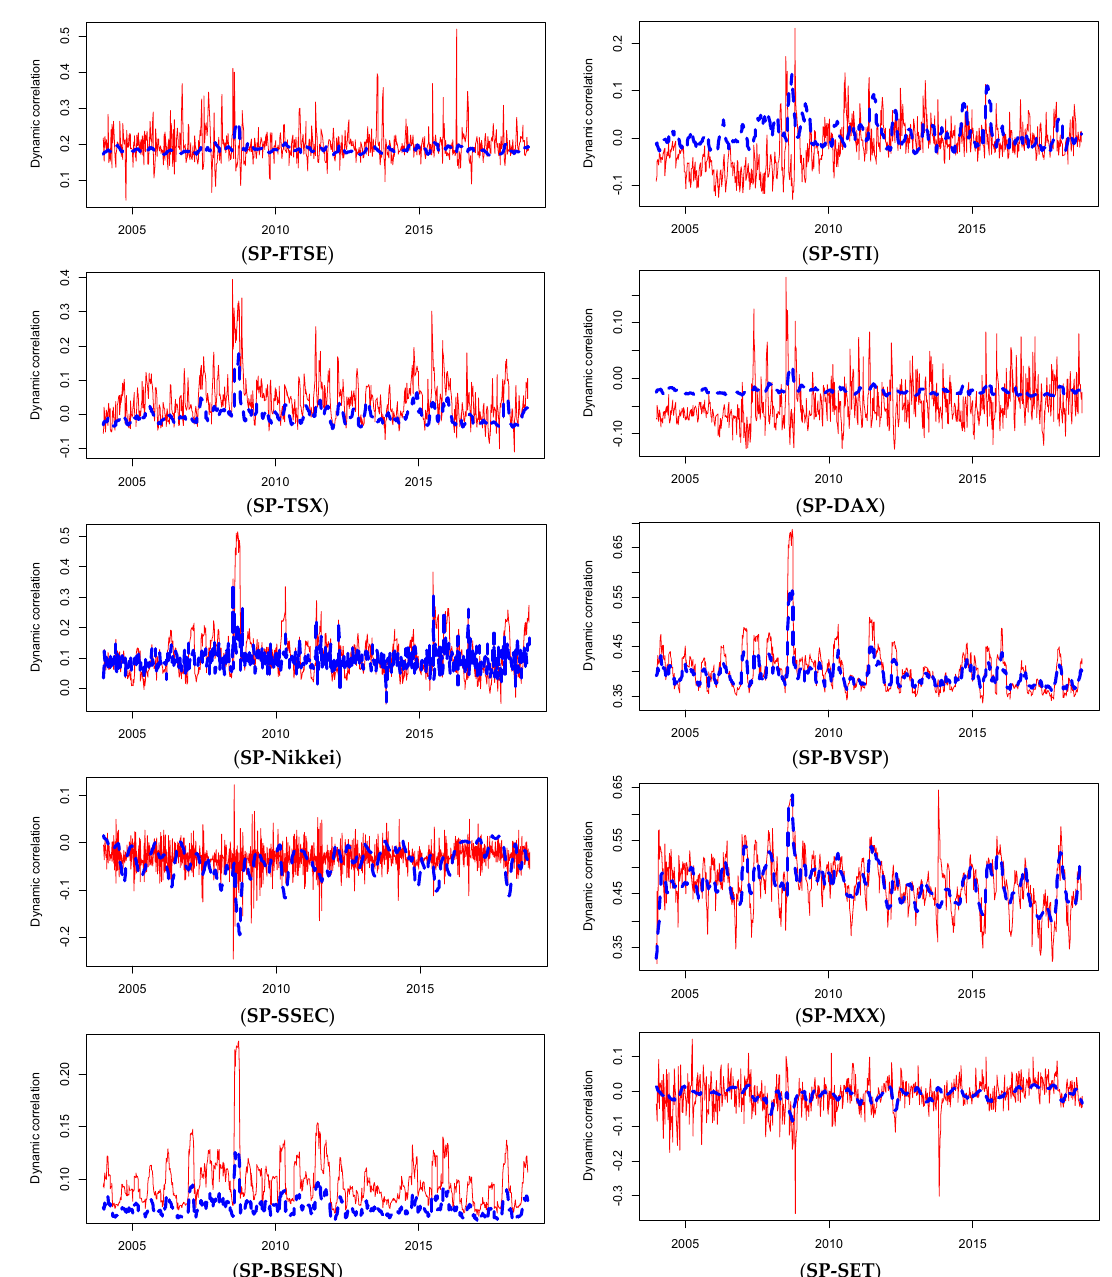
Figure 1. Time-varying Kendall’s tau between the US market and other markets (2004–2018). Note that the blue dashed line is dynamic copulas without AGI, and the red line is dynamic copulas with AGI. The time-varying paths of conditional correlations for the paired returns were calculated by the parameters obtained from the best fit time-varying copula models presented in Table 8.